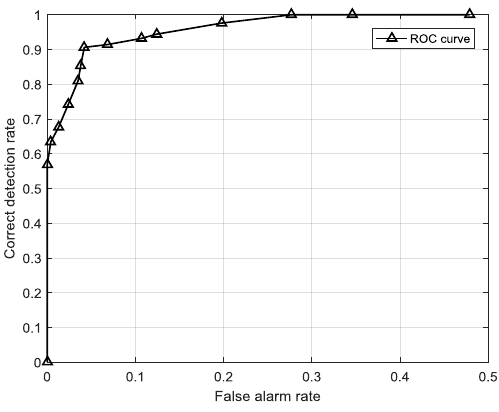
Figure 15. ROC curve of the estimation-based model with different thresholds.